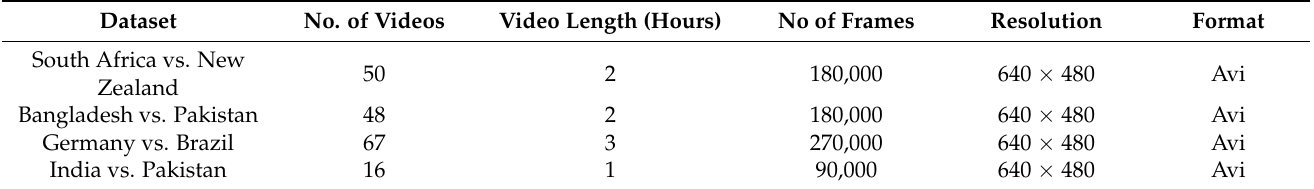
Table 2. Description of